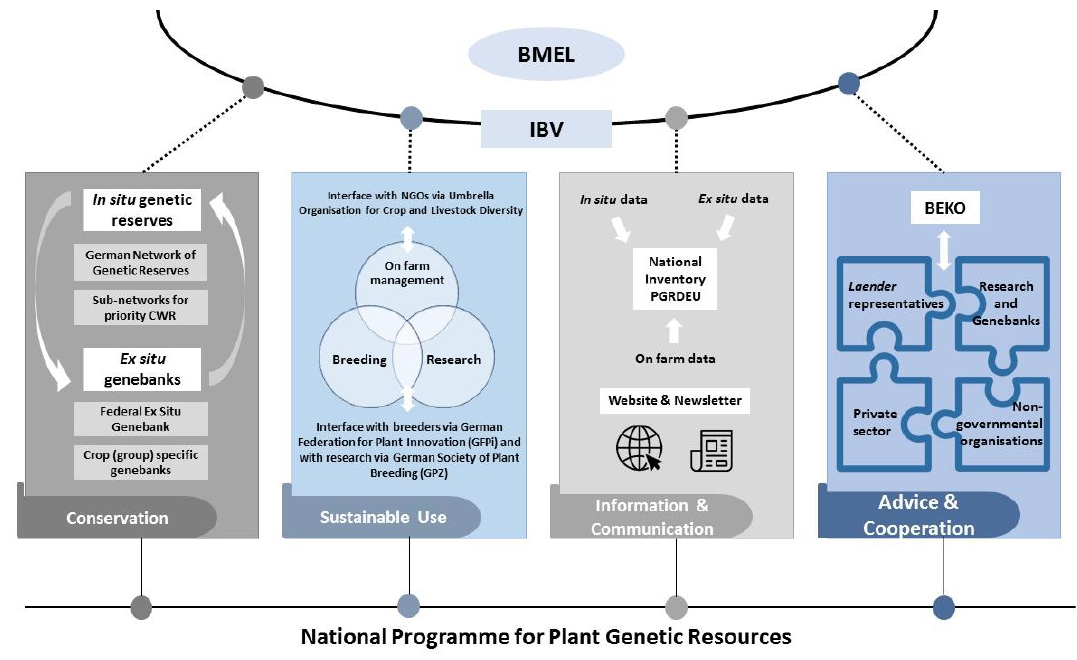
Figure 3. Coordination and governance structure of the German plant genetic resources system.